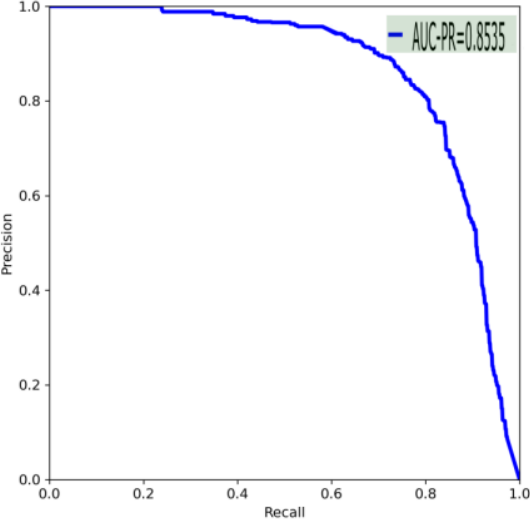
Figure 15. PR curve.